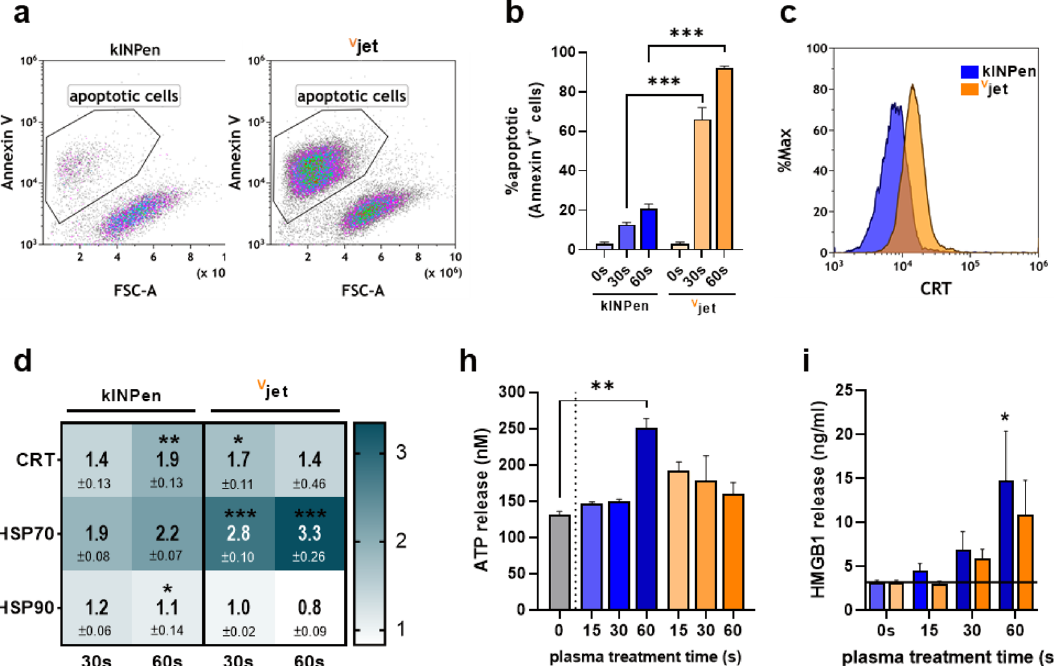
Figure 3. Immunogenic cell death in cancer cells following plasma treatment. ( a ) representative flow cytometry dot plots of annexin V + cells 24 h after plasma treatment and ( b ) quantification thereof; ( c ) representative flow cytometry intensity histogram of CRT surface expression and ( d ) quantification of ecto-CRT, HSP70, and HSP90 normalized to untreated controls; quantification of ( e ) ATP and ( f ) HMGB1 release in cell culture supernatants after plasma treatment. Data are representative of three independent experiments. Statistical analysis was performed using two-way Anova (*p < 0.05; **p < 0.01; ***p <